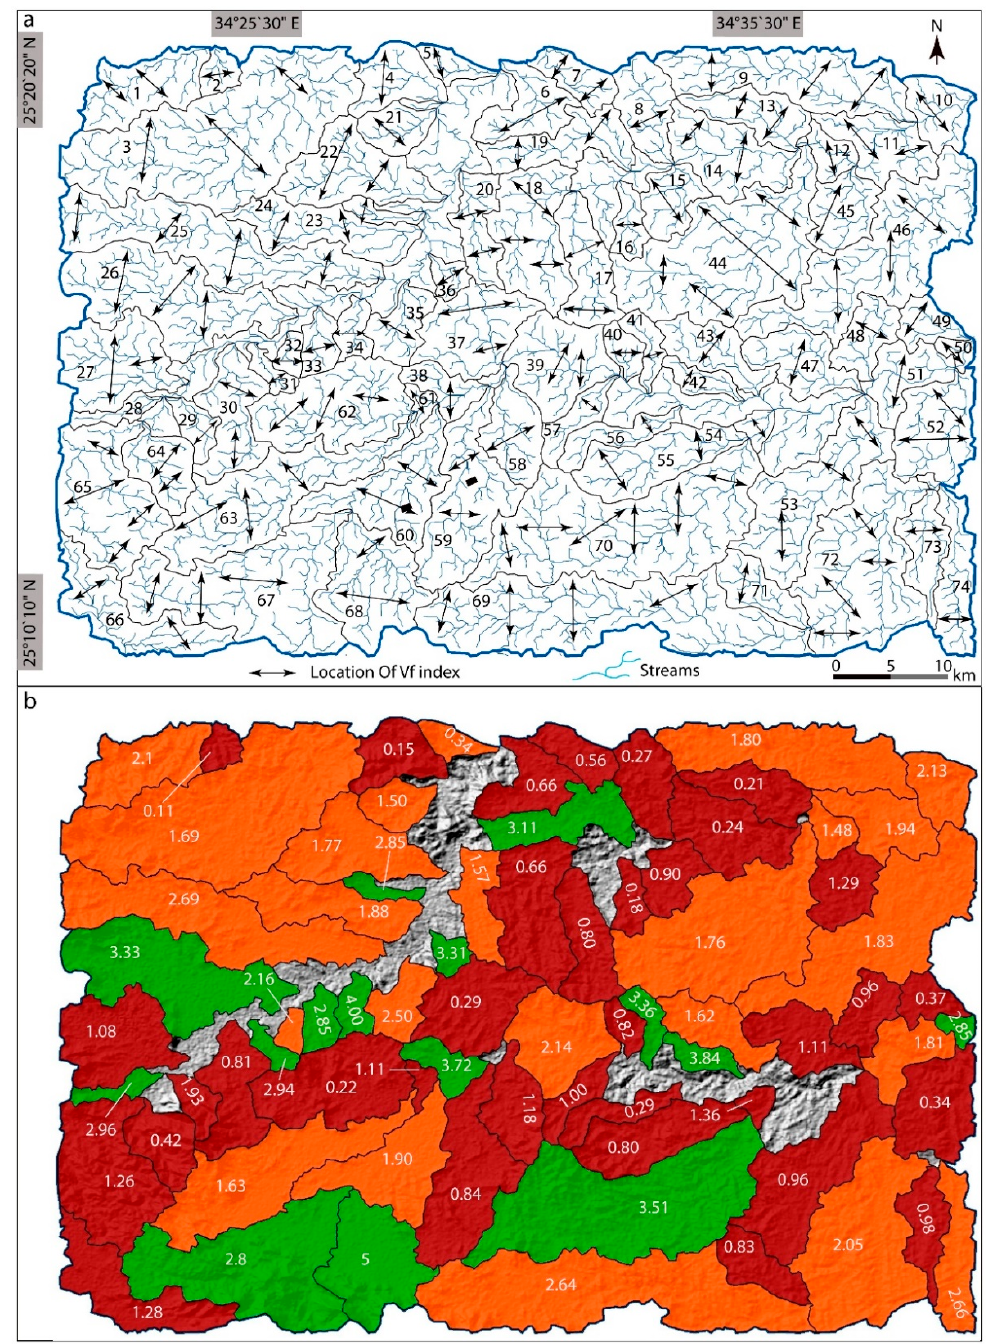
Figure 5. ( a ) Location of V f calculation sections. Black numbers refer to the sub-catchment reference number. ( b ) Values and classes of V f index for 74 identified sub-catchments. White numbers refer to the V f values.